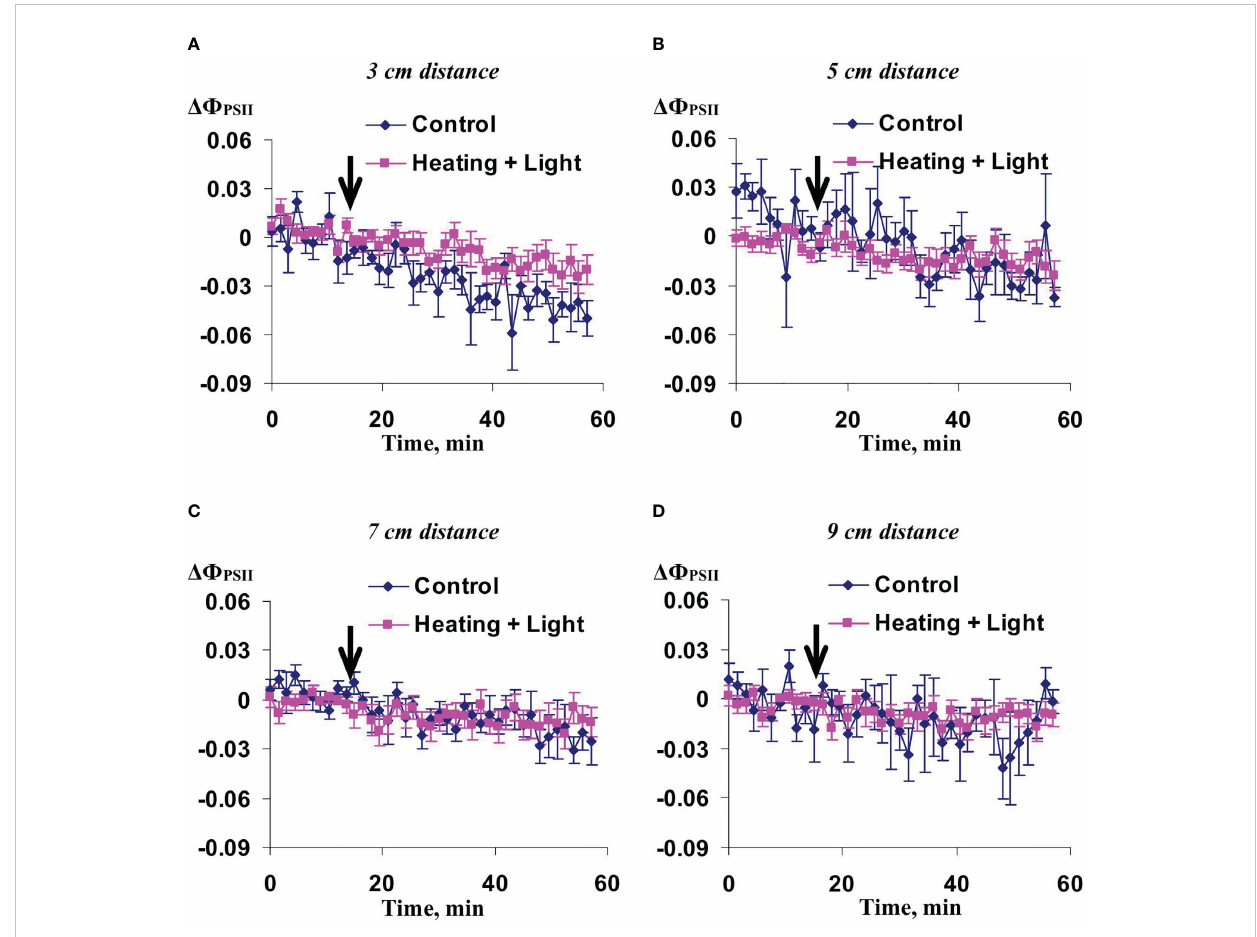
FIGURE 8 Averaged changes in the quantum yield of photosystem II ( D Ф PSII ) in 3 cm (A) , 5 cm (B) , 7 cm (C) , and 9 cm (D) from zone of the local action of combination of heating and blue light in wheat plants after 14-day soil drought ( n =12). Arrow marks initiation of this action; control plants were